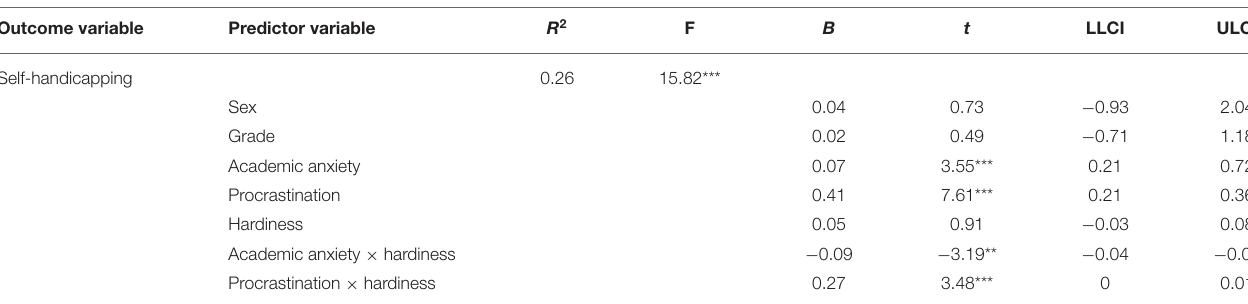
TABLE 4 | The moderation model of